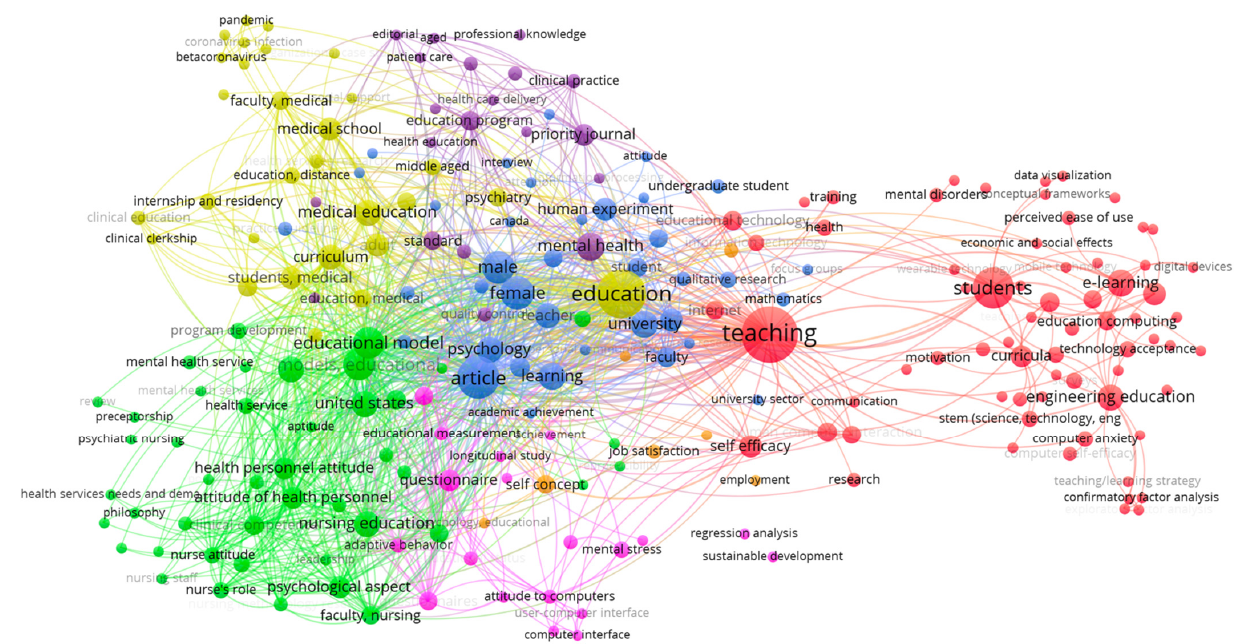
Figure 5. Co-occurrence of the repetitive terms identified per article. Table 7. Main keywords used by the communities detected in the topic